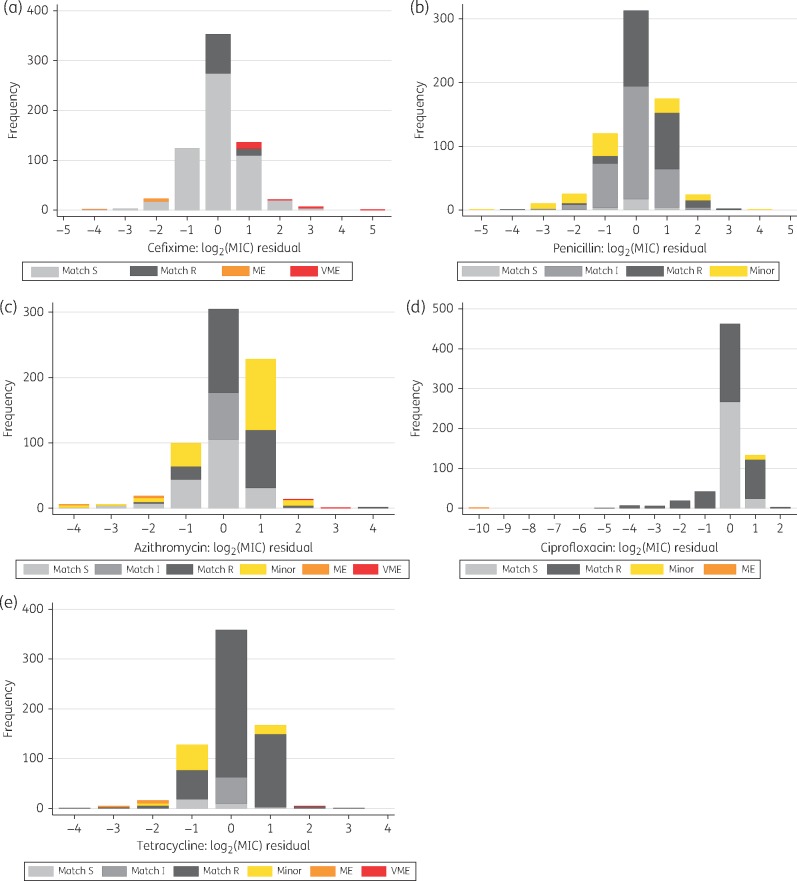
Accuracy of predicted MICs. The difference between the measured and predicted MICs is shown on a log2 scale, such that a difference of 1 represents a difference of 1 doubling dilution. A VME is where the predicted susceptibility is susceptible when the measured susceptibility is resistant; an ME is where the predicted susceptibility is resistant, but the measured susceptibility is susceptible; and minor errors denote where the phenotype is susceptible and the prediction intermediate, or the phenotype is intermediate and the prediction is resistant, or vice versa in both cases. S, susceptible; I, intermediate; R, resistant; ME, major error; VME, very major error.